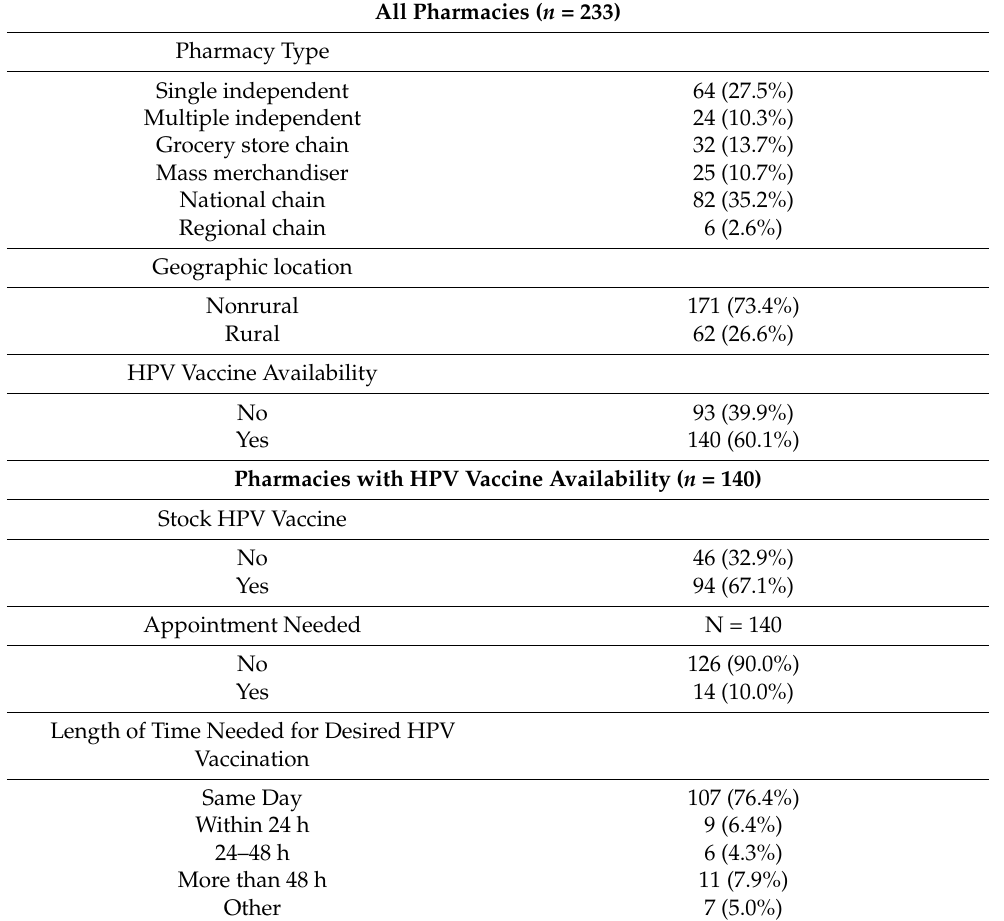
Table 1. Pharmacy